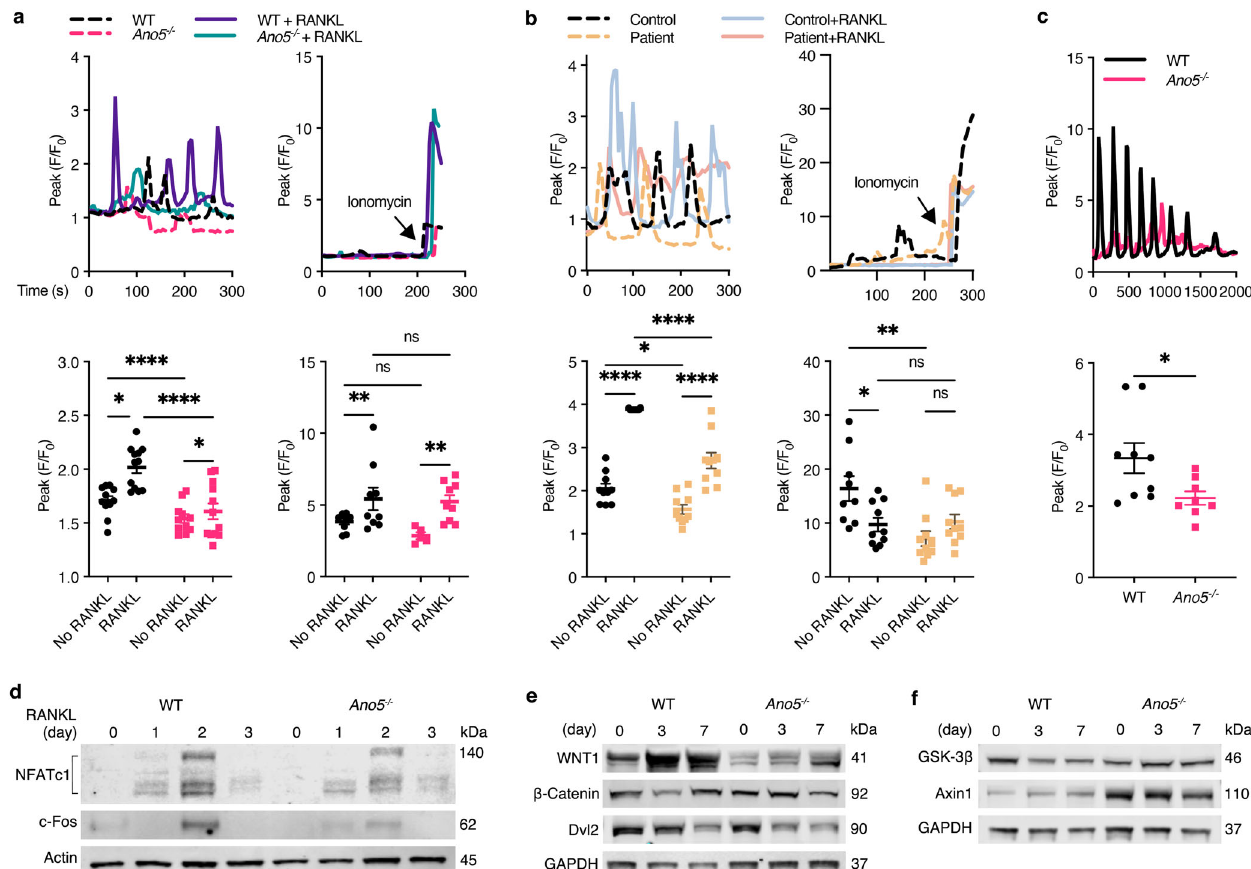
Fig. 5 LOF of TMEM16E impairs intracellular calcium oscillations. a RANKL-induced oscillatory changes in [Ca 2 + ] i from Ano5 − / − and WT BMMs (left) and after the addition of 10 mM ionomycin at the end of each experiment (right). b RANKL-induced oscillatory changes in [Ca 2 + ] i in PBMCs from patients and healthy controls (left) and after the addition of 10 mM ionomycin at the end of each experiment (right). c Oscillatory changes in [Ca 2 + ] i during osteogenic differentiation of Ano5 − / − and WT calvarial osteoblasts. d NFATc1 and c-Fos expression as assessed by Western blotting of WT and Ano5 − / − BMM nuclear samples during osteoclast differentiation. e WNT1, β -Catenin, Dvl2, f GSK-3 β , Axin1 expression as assessed by Western blotting of osteoblast samples from WT and Ano5 − / − mice during osteoblast differentiation. Fluorescence intensity values over time (normalized to minimum intensity values) were calculated for each cell. Analysis of the peak fl uorescence intensity per fi ring cell over an observation period. Data are represented as the mean ± SEM. All results are representative of data generated from at least three independent experiments. Two-tailed Student ’ s t -test (for c ), two-way ANOVA (for a , b ) followed by Tukey ’ s multiple comparisons test. * P < 0.05, ** P < 0.01, **** P < 0.0001; ns: not signi fi cant P > childhood and adolescence. Additionally, Li, H. et al., Kim, J. H. osteoblasts and osteoclasts in Annexin V binding assays were et al., and our study reached the same conclusion that Ano5 similar to that of WT osteoblasts and osteoclasts either in the signi fi cantly enhanced RANKL-induced osteoclast differentiation presence or absence of cytosolic Ca 2 + (Supplementary Fig. 4). In and bone resorption via multiple signal transduction pro- that case, GOF of TMEM16E protein results in high-bone-mass cesses 46,47 . Therefore, low bone resorption activities in elderly phenotype GDD by hyperfunction of PLS with increased osteoblast and osteoclast indices, while LOF of TMEM16E protein GDD patients explain why their bone mass is still maintained at causes low-bone-mass phenotype GDD by impaired function of normal or even increased levels when ordinary elderly people calcium oscillations with decreased osteoblast and osteoclast develop osteoporosis. Similarly, Wang, X. et al. and Jin, L. et al. indices. Overall, our results suggest the existence of GDD-sub- found that Ano5 -de fi cient and Ano5 KI/KI p.Cys360Tyr mutation entities with high and low BMD phenotypes due to different GOF mice showed increased BMD in cortical bones but reduced and LOF mutations and functions. trabecular thickness in femurs and tibias by using 12- and 16- Recently, Jin, L. et al. noticed that expression levels of two week-old mouse models as research objects 15,45 . As an age- mutant TMEM16E proteins (p.Cys356Tyr, p.Cys360Tyr) were much related disease, the onset of GDD occurs at a very young age, lower than those of wild-type TMEM16E, which is consistent with mostly in juveniles between 10 and 16 years old; thus, by using our fi nding of low TMEM16E expression with the LOF ANO5 12-week-old and even 16-week-old mice as models of young frameshift mutation 45 . In their study, the 73-year-old proband did adults and middle-aged humans, osteoporosis symptoms may be masked by aging changes in mice. The authors also noticed that not experience frequent fractures and exhibited thickening of the calvaria-derived Ano5 − / − and Ano5 KI/KI osteoblasts show cortical long bones in the family with ANO5 p.Cys360Tyr mutation, while the 15-year-old proband suffered repeated fractures in the increased mineralization and osteoblastogenesis, which partly family with ANO5 p.Cys365Tyr mutation 45 . Our observations also contradicts our conclusions 15,45 . According to our Von Kossa showed a more obvious severe clinical phenotype and abnormal staining, OCN immunohistochemistry, and calcein/AR double- bone turnover markers in patients of young ages, especially in labeled sections of Ano5 − / − mouse femurs and osteoblast